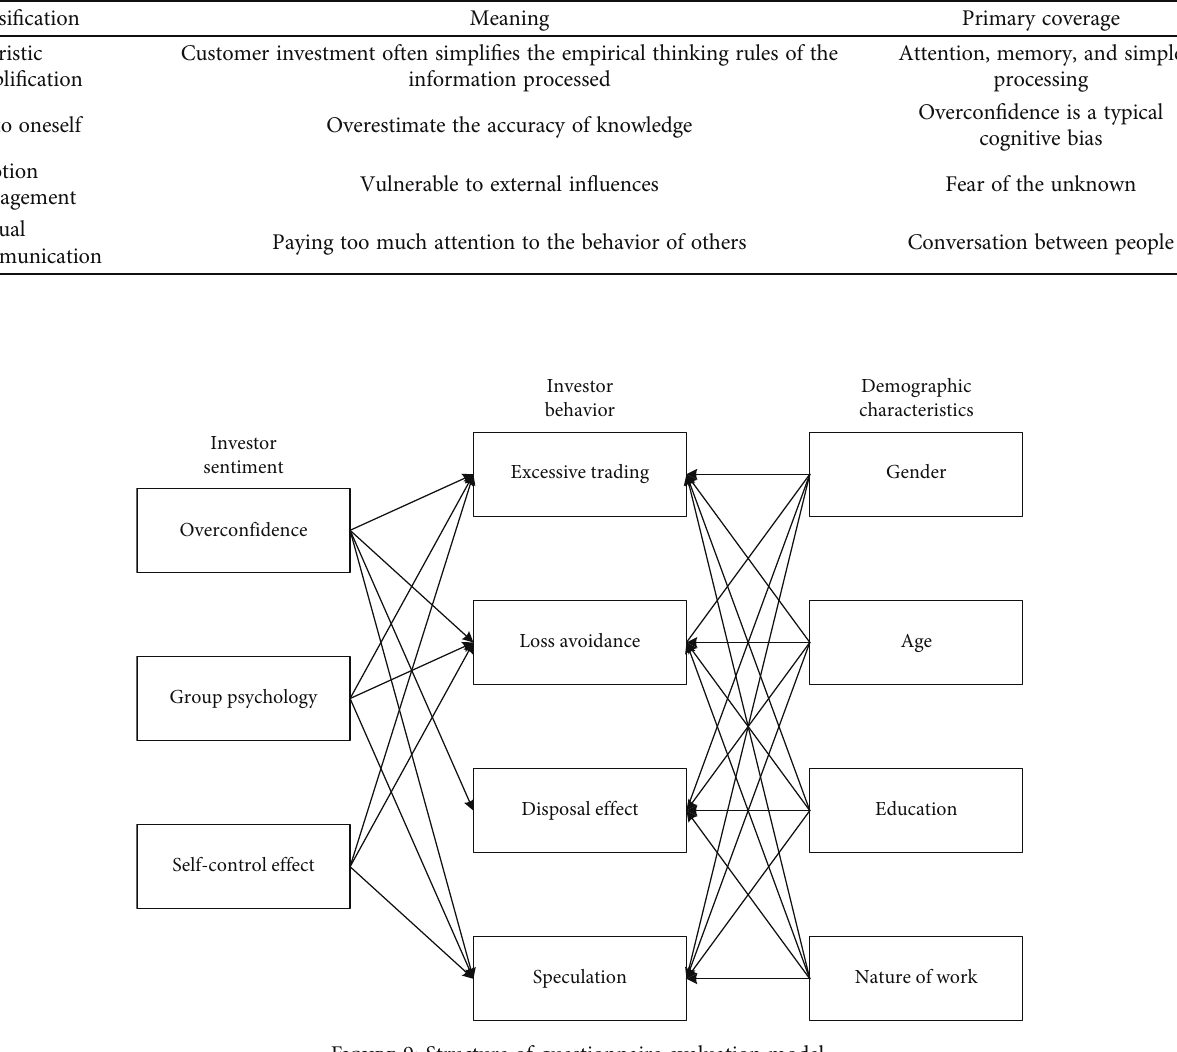
Table 2: Types of cognitive customers ’ emotional deviation.